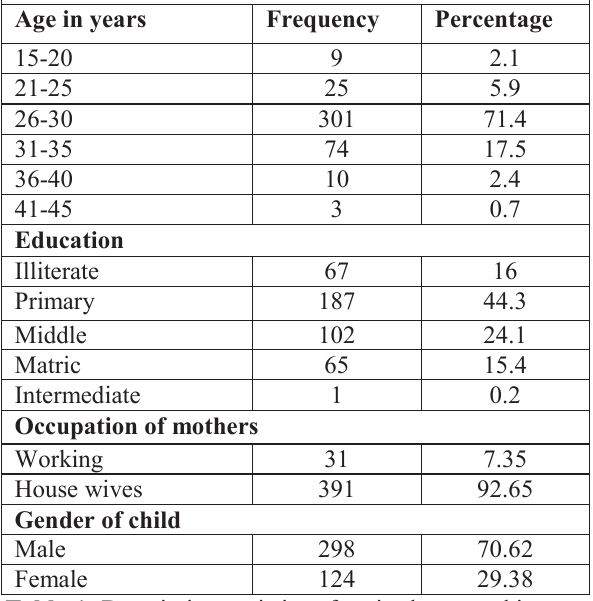
Table-1: Descriptive statistics of socio-demographic factors of mothers of children aged under 5.